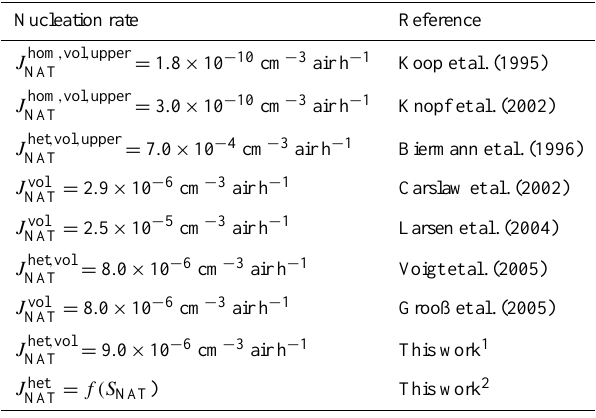
Table 1. NAT nucleation rates from previous studies, as described in the text. All rates except for f (S NAT ) are air-volume-based, and lead to NAT nucleation as soon as the temperature drops below T NAT